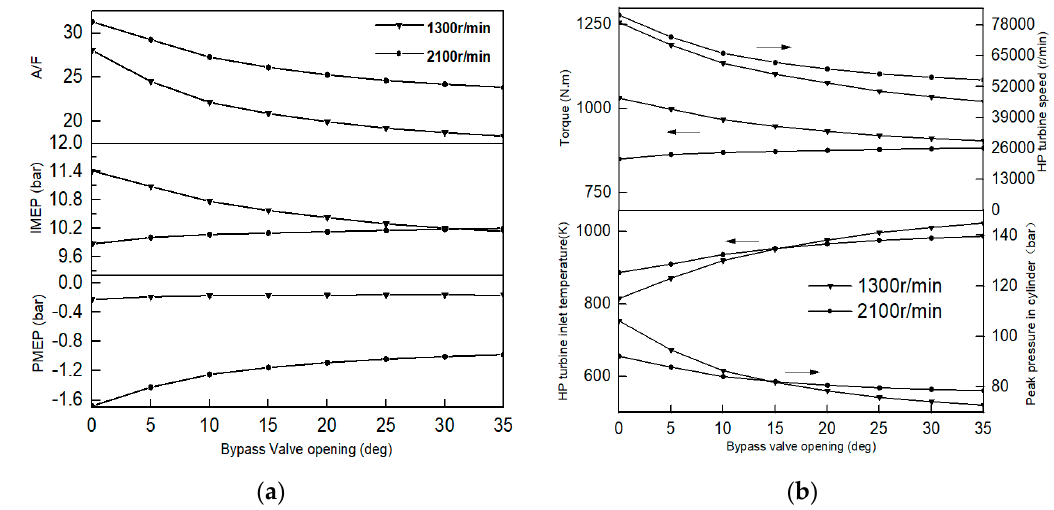
Figure 3. The influence of bypass valve opening. ( a ) on peak pressure in a cylinder ( p max ), HP turbine inlet temperature ( T ex ), and rotation speed of the HP turbocharger ( n htc ); ( b ) on air fuel ratio (AFR), indicated mean effective pressure (IMEP), and pump mean effective pressure (PMEP).